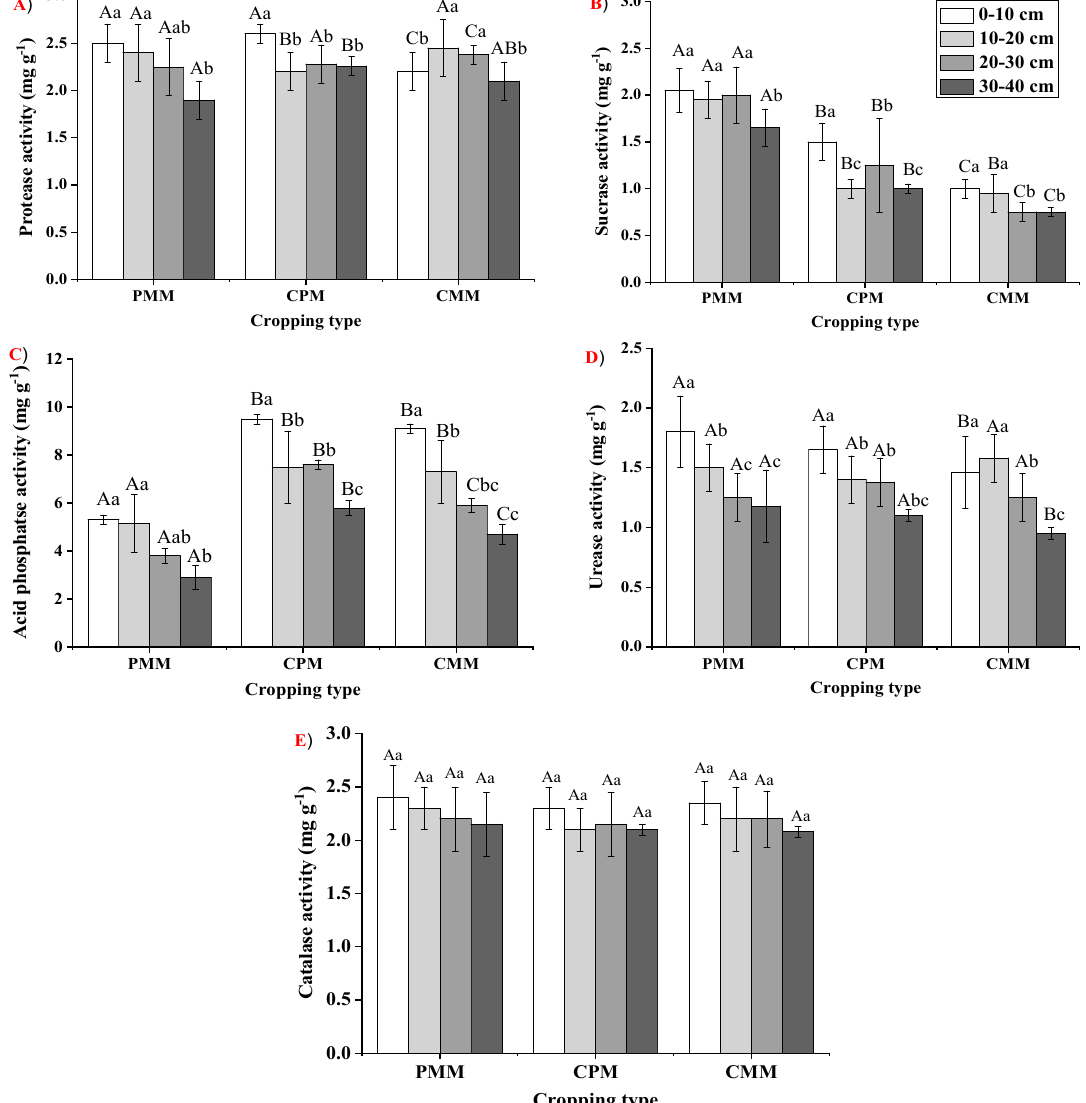
Figure 3. The activity of soil enzymes ( A ) protease; ( B ) sucrase; ( C ) acid phosphatase; ( D ) urease; and ( E ) catalase (mg.g − 1 ) at different soil depths in the three cropping models in the study site. A two-way analysis of variance (ANOVA) test was conducted and the values in the columns were the mean ± SD. Different uppercase letters indicated significant differences between the cropping systems at p < 0.05, while different lowercase letters indicated significant differences among soil depths p <